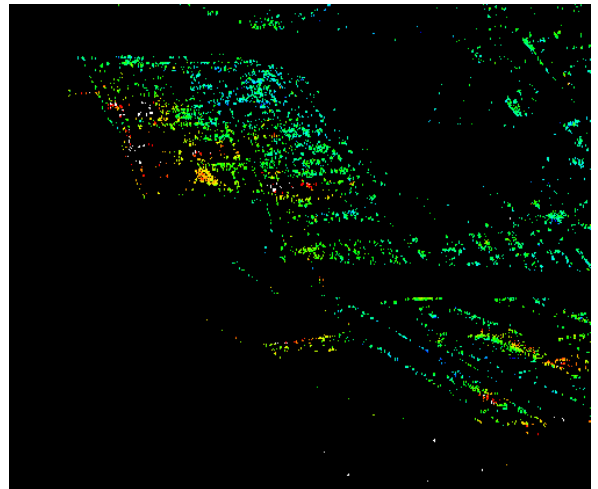
Figure 3. Deformation velocity map from the PSI approach. The colour scale ranges from – 10 to + 10 mm/yr.